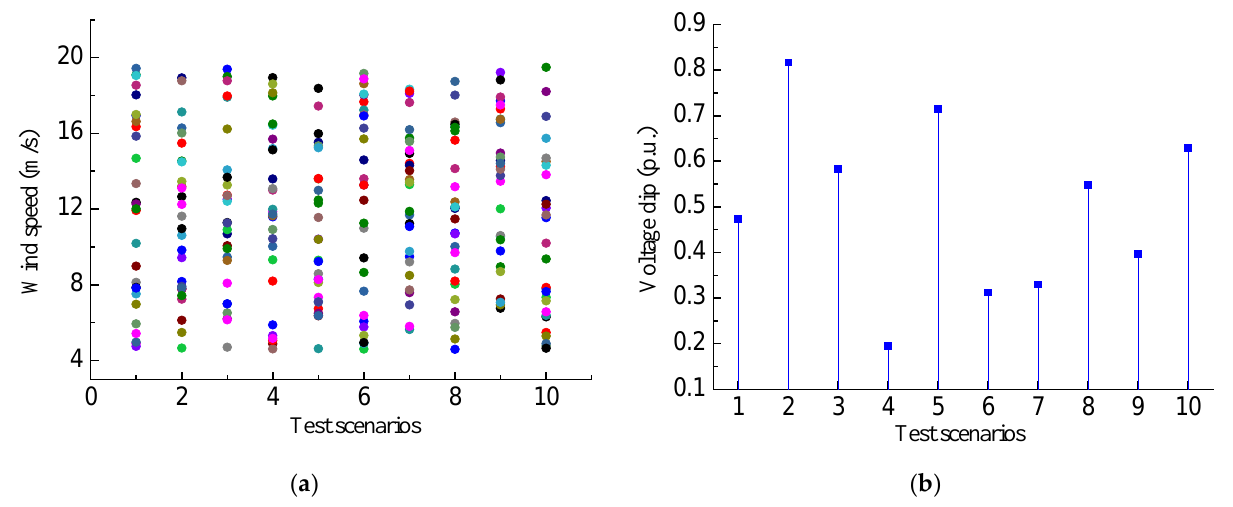
Figure 4. Ten test scenarios. ( a ) Wind speed scenarios. ( b ) Voltage dip scenarios. Under the operation conditions of Figure 4, the dynamic responses at the POC of the DM, MM1, MM2 and PM were sampled. The active and reactive power errors of different equivalent WF models were calculated according to Equations (4) and (5), respectively, as presented in Tables 2 and 3. According to the values given in Tables 2 and 3, the differ- ences in accuracy of the three equivalent models are illustrated in Figures 5 and 6, respec- tively. Table 2. Active power response error of three equivalent models.